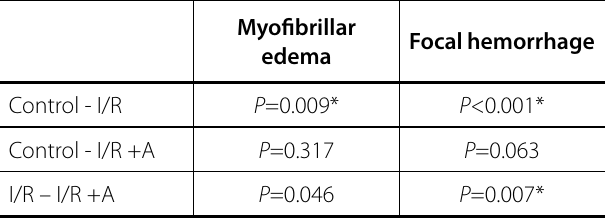
Table 2. Comparison of the groups regarding myofibrillar edema and focal